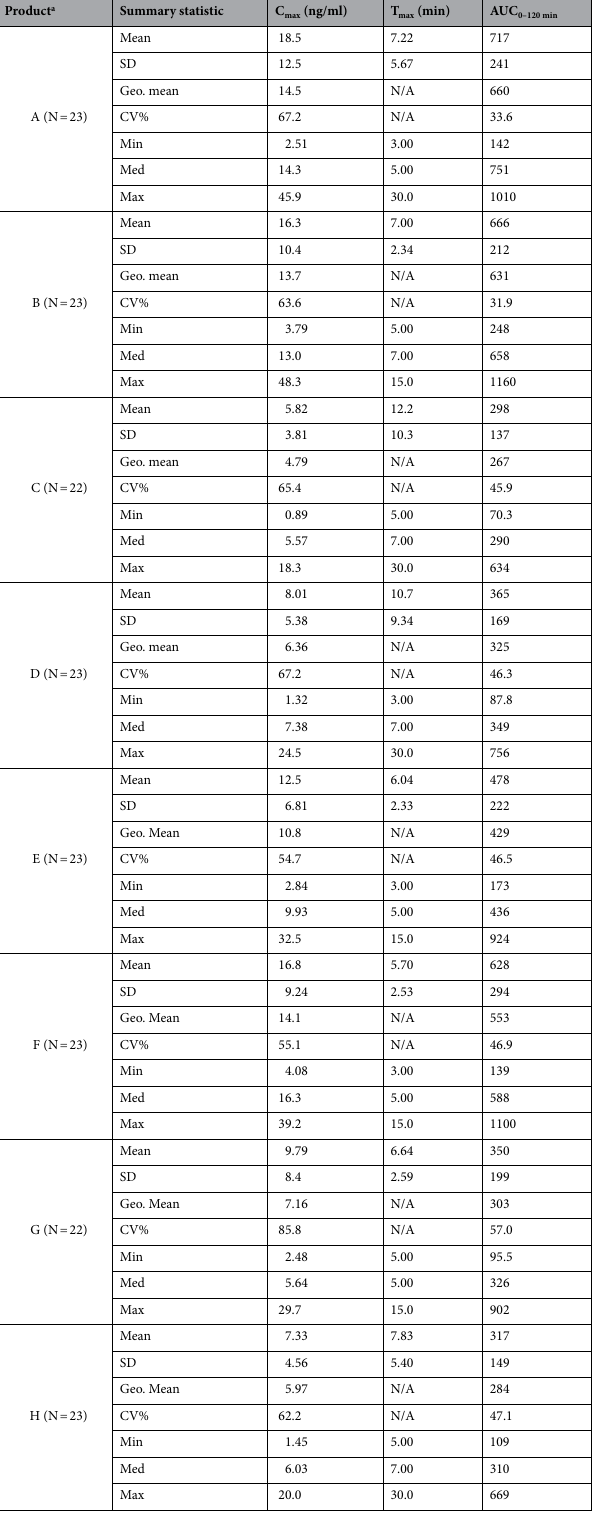
Table 3. Arithmetic mean (95% CI) plasma nicotine concentration time profiles of investigational products (PK set). N number of subjects; SD standard deviation; CV coefficient of variation; Geo. Mean geometric mean. a Products: A, combustible cigarette (ad libitum); B, combustible cigarette (fixed); C, ePen2.0BT18 (ad libitum); D, ePen3.0BT18 (ad libitum); E, ePen3.0MB18VP (ad libitum); F, ePen3.0MB30VP (ad libitum); G, -ePen3.0MB18VP (fixed); H, ePen3.0MB12VP (ad libitum). PK population dataset: of 24 subjects enrolled, one dropped out and one did not fulfil the study criteria for Products C and G (see